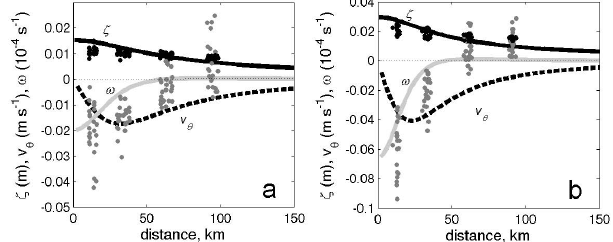
Fig. 5. Radial profiles of ζ (m, solid black line), v θ (ms − 1 , dash line) and ω (10 − 4 s − 1 , solid grey line) of the surface signal of a meddy with R m = 35km, H = 1100m and |˜ q m | = 0 . 7 f ; (a) in the northern tropics ( f =7.3 × 10 − 5 s − 1 , N =3 × 10 − 3 s − 1 ) , (b) in the subtropics ( f =8.5 × 10 − 5 s − 1 , N =2.5 × 10 − 3 s − 1 ) . Observed ra- dial profiles of ζ (m, black dots) and ω (10 − 4 s − 1 , grey dots) of surface signals of meddy Hyperion (the part of the trajectory south of 32 ◦ N) and meddy Zoe are overlaid on plates (a) and (b) , respec- tively. Fig. 6. (a) Variations of meddy-core peak relative vorticity ( ω m –